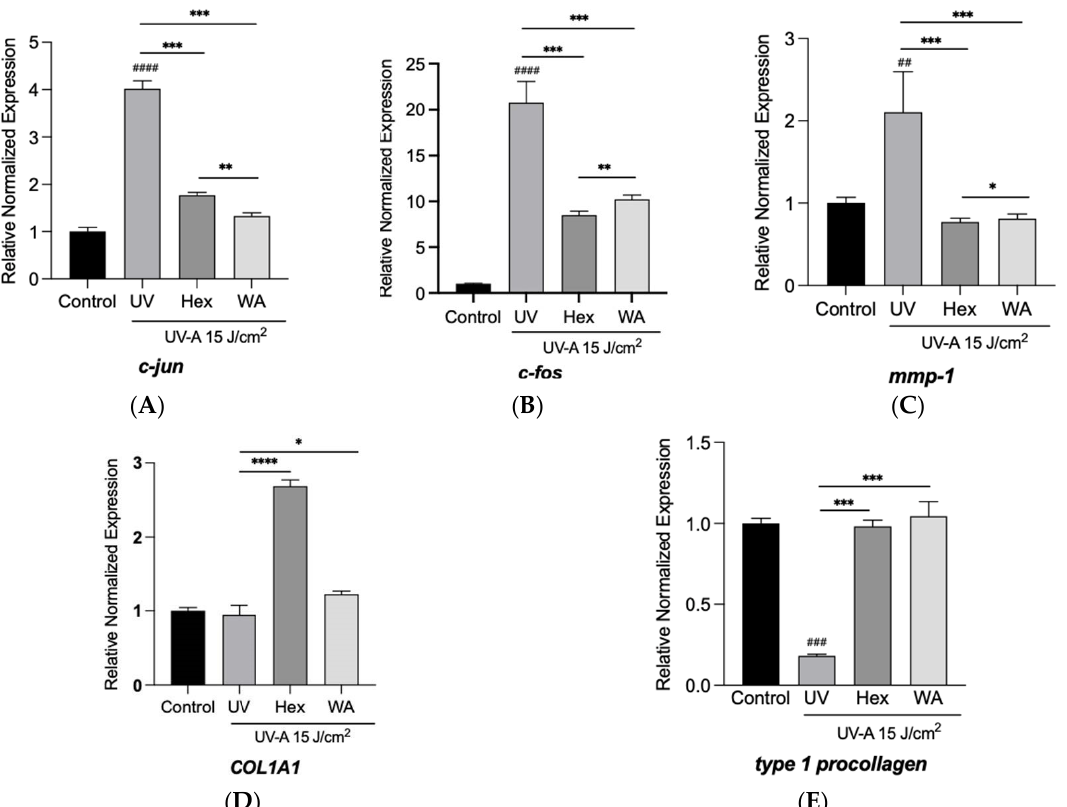
Figure 8. Effects of the fractions of fermented turmeric milk on skin-associated genes expression in UVA-exposed Hs68 cells. ( A ) c-jun , ( B ) c-fos , ( C ) mmp-1 , ( D ) COL1A1 , ( E ) type 1 pro-collagen . Control: group without UV-A irradiation; NC: irradiated with 15 J/cm2 without other treatment; NAC: 1 mM N-acetylcysteine; Hex: 100 ppm n-hexane extract of fermented turmeric milk; WA100: 100 ppm fermented turmeric drink water. Residual layer test results are repeated three times and expressed as mean ± standard deviation. Statistics were analyzed by t -test, ## = p < 0.01 vs. Control, ### = p < 0.001 vs. Control, #### = p < 0.0001 vs. Control. * = p < 0.05, ** = p < 0.01, *** = p < 0.001, **** = p < 0.0001.